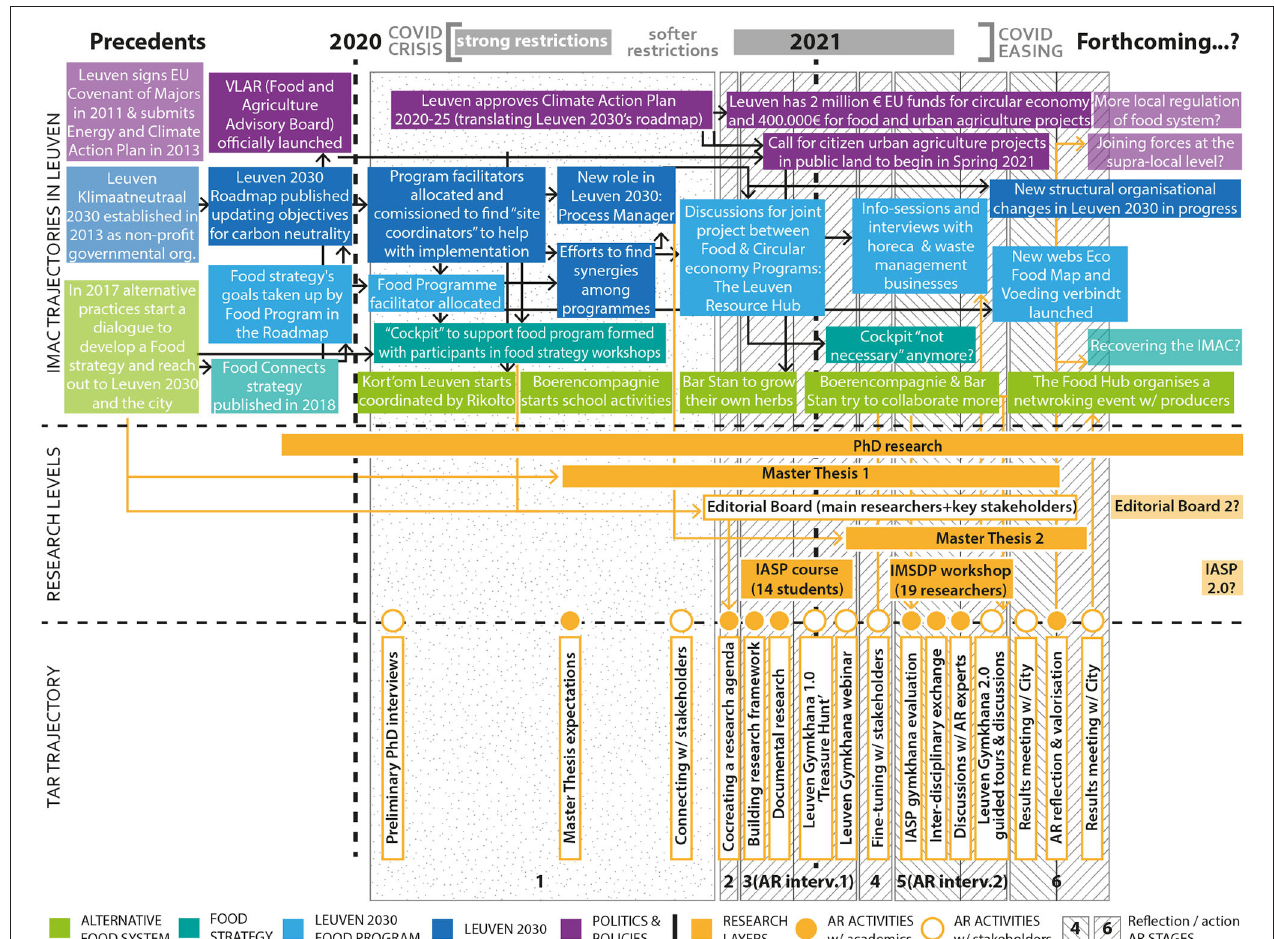
FIGURE 1 | Timeline describing key moments and actors in the IMAC trajectories investigated (top), the research levels involved in the TAR (middle) and the specific TAR activities and stages (bottom).